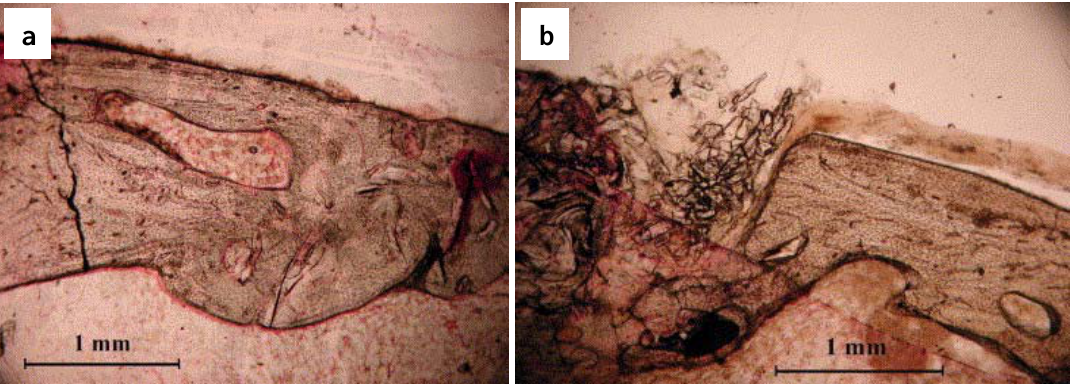
Figure 11. Optical micrograph from histological sections of tibial bone defects after